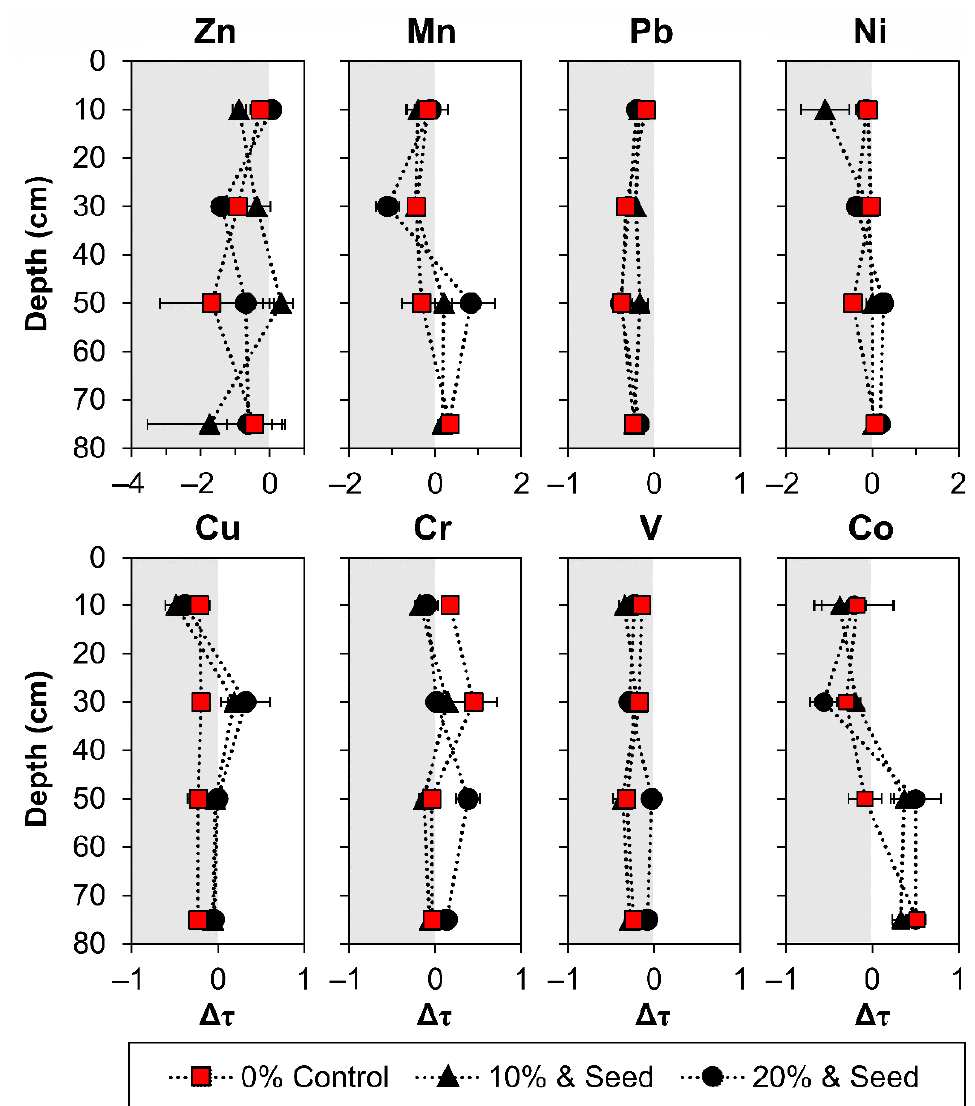
Figure 3. Mass transfer dynamics in field cores. The change in enrichment/depletion ( ∆ τ ) of each metal from the beginning to end of phytostabilization are shown for the control and seeded 10% and 20% plots. Error bars show standard deviation among samples collected from quadruplicate field plots, n = 4. Depth is plotted as the mid-point of each homogenized core depth increment.